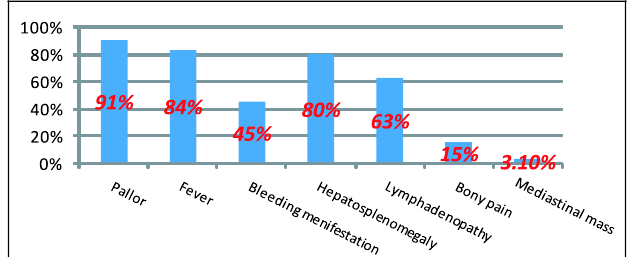
Fig 1. Clinical manifestations of study subjects